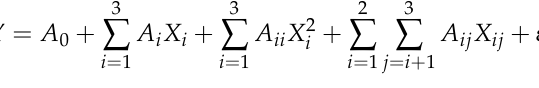
Table 1. Central composition design of hydrothermal extraction of Acer tegmentosum . Coded Levels Independent Variables Units Symbol − α − 1 0 1 α Extraction temperature ◦ C X 1 63.18 70 80 90 96.82 Extraction time h X 2 0.64 2 4 7.36 Solvent-to-solid ratio mL/g X 4 15.91